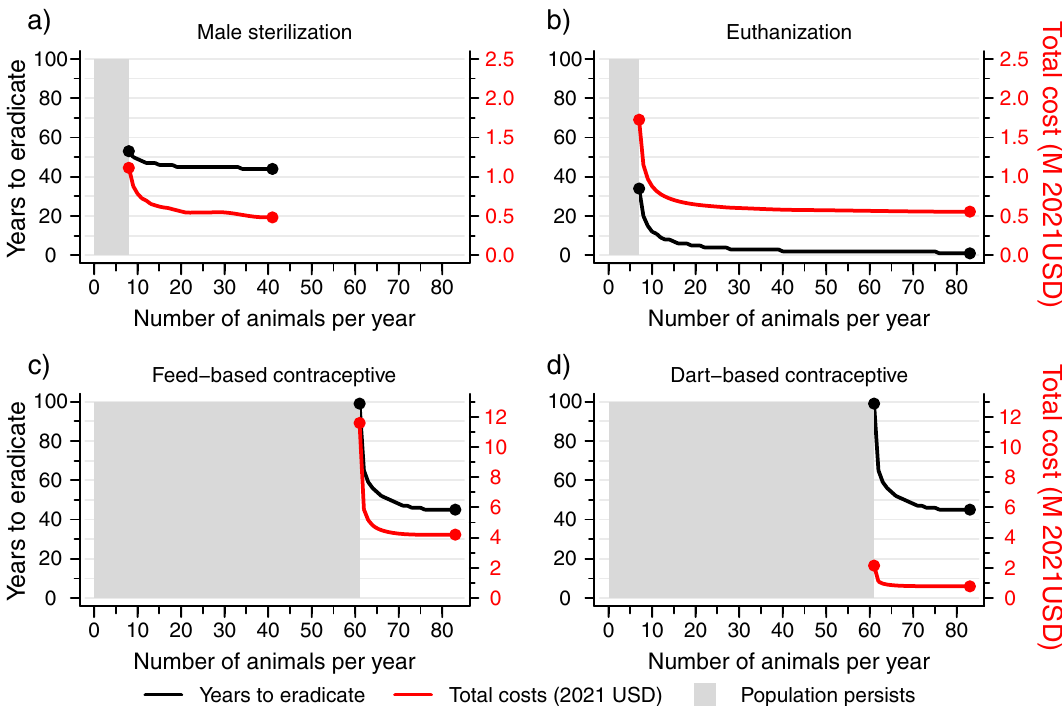
Figure 4. Estimated time to eradication (left y-axis) and total costs (right y-axis, 2021 USD) for different management interventions to control introduced hippos in the Magdalena River basin, Colombia. Management interventions (a-d) assume a fixed numbers of animals (x-axis) are addressed each year starting from 2022 until eradication is achieved. The minimum number of animals that could be addressed annually and still lead to hippo eradication differs across control strategies; treating fewer than this minimum number of hippos annually will lead to long term hippo population persistence (gray polygons). The standing stock of hippos may drop below the target annual animal treatment number under a given management intervention; thus, costs are calculated as the realized total number of animals addressed to achieve eradication under a given intervention approach multiplied by a per-individual treatment cost.